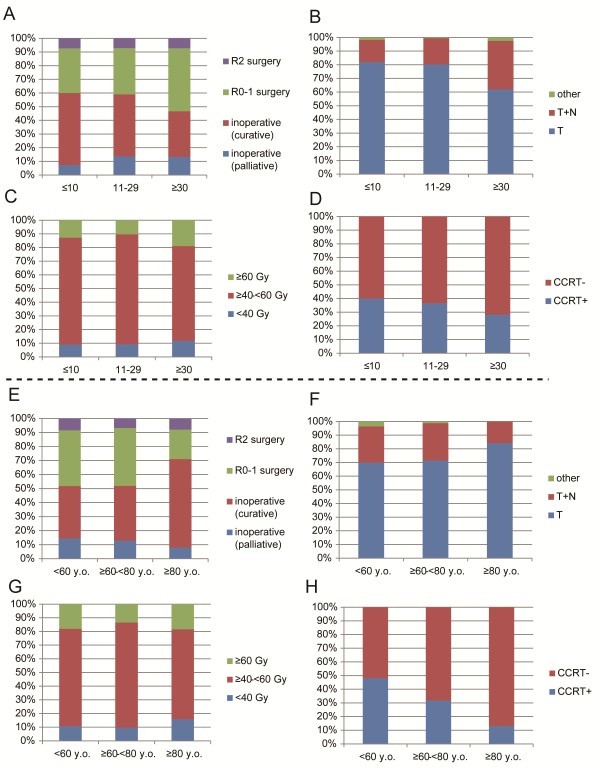
Practice patterns of EBRT according to caseload of institutions or patient age. Three categories were formed based on the number of patients treated at each institution (≤10, 11–29 and ≥30 patients) (A-D) or age (<60, ≥60- < 80, and ≥80 years old) (E-H) and evaluated based on treatment intent (A, E), EBRT field size (B, F), EBRT total dose (C, G), and concurrent chemotherapy (D, H).